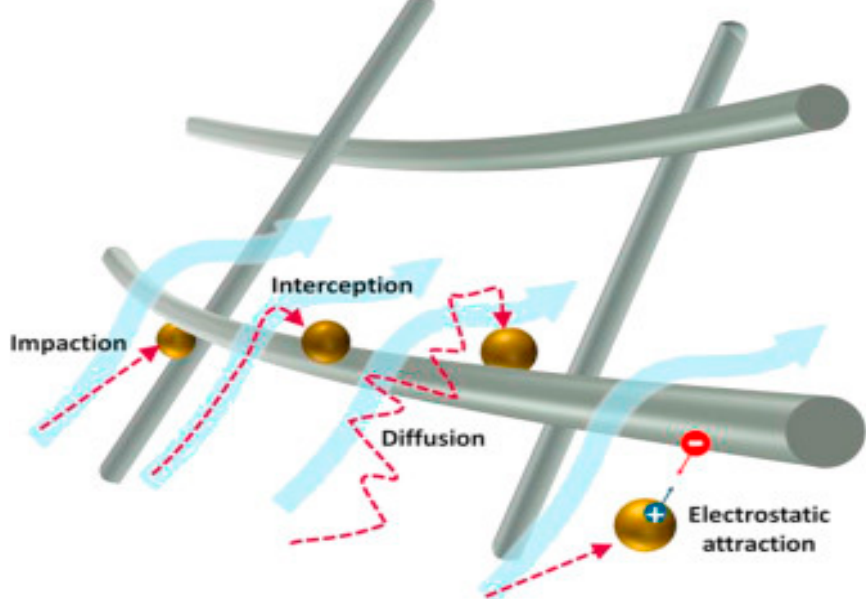
Figure 1. Filtration mechanism of face coverings [27].